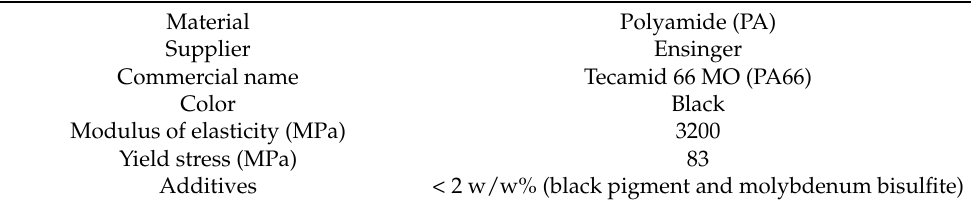
Table 1. Details of the polymeric material used for the joint production.